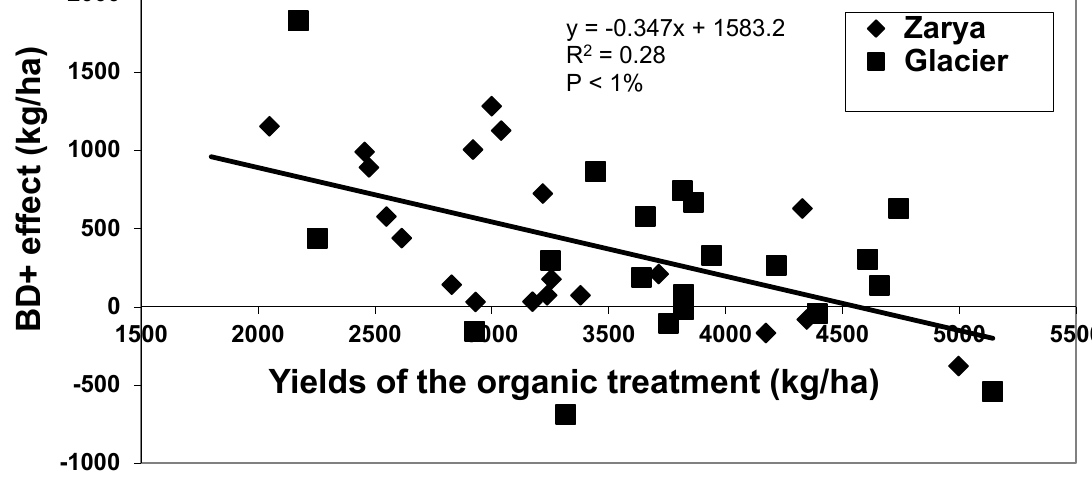
Figure 2: The effects of the BD+NCP treatment on the yields of winter wheat relative to the organic treatment